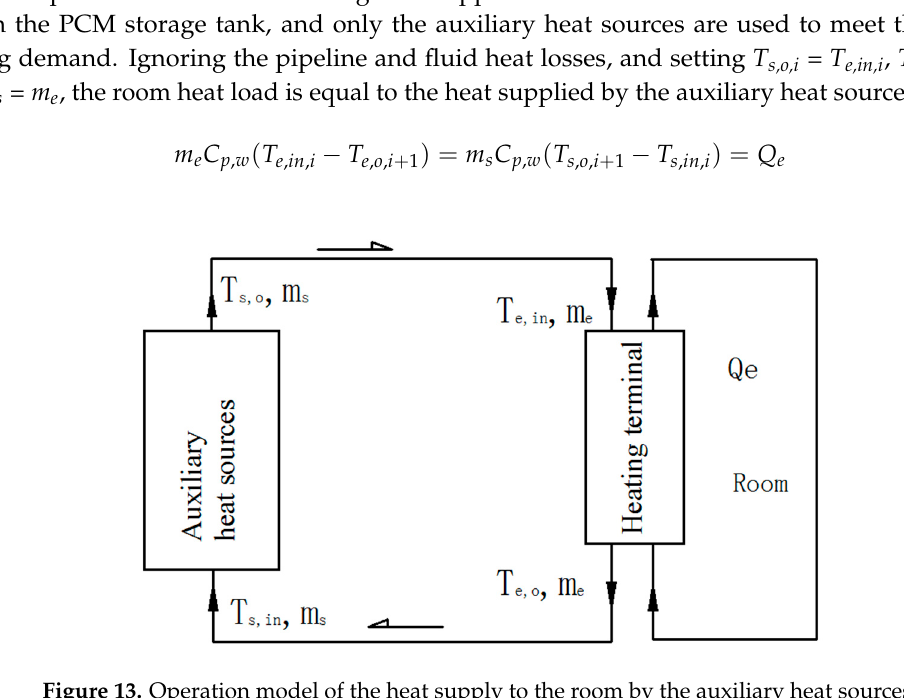
Figure 12. Operation model of the heat supply to the room from the phase-change thermal tank and auxiliary heat sources.